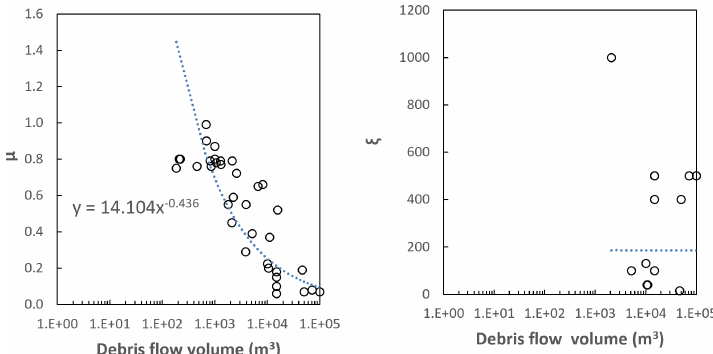
Figure C2. Debris flow: range of parameters used to back analyse the runout of debris flows published in the literature ( n = 22), using the RAMMS software.